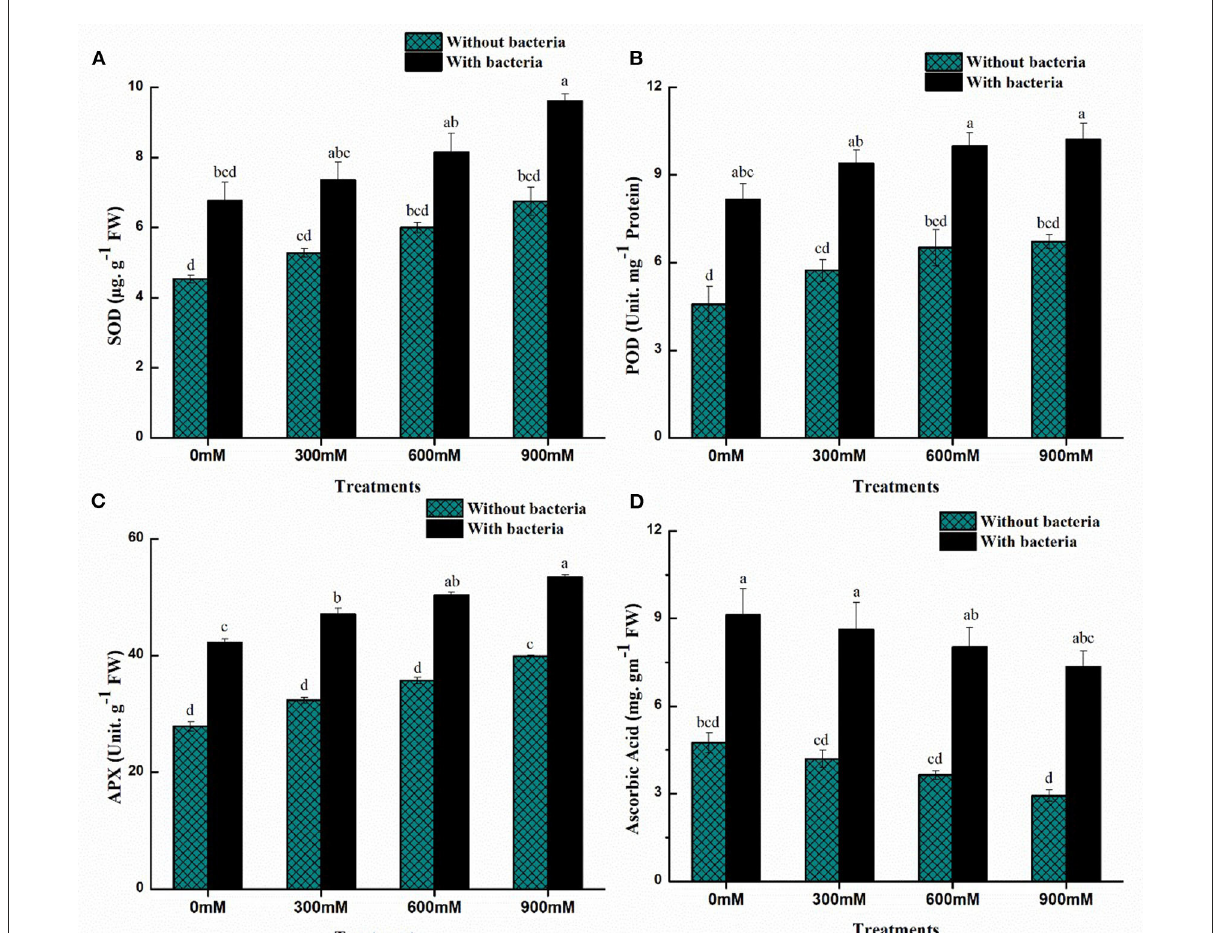
FIGURE4 Effects of Bacillus thuringiensis PM25 on levels of enzymatic and non-enzymatic antioxidants: (A) APX (B) POD (C) SOD (D) Ascorbic Acid. Bars sharing different letter (s) for each parameter are significantly different from each other according to the LSD test ( p ≤ 0.05). All the data represented are the average of three replications ( n = 3). Error bars represent the standard errors (SE) of three replicates.